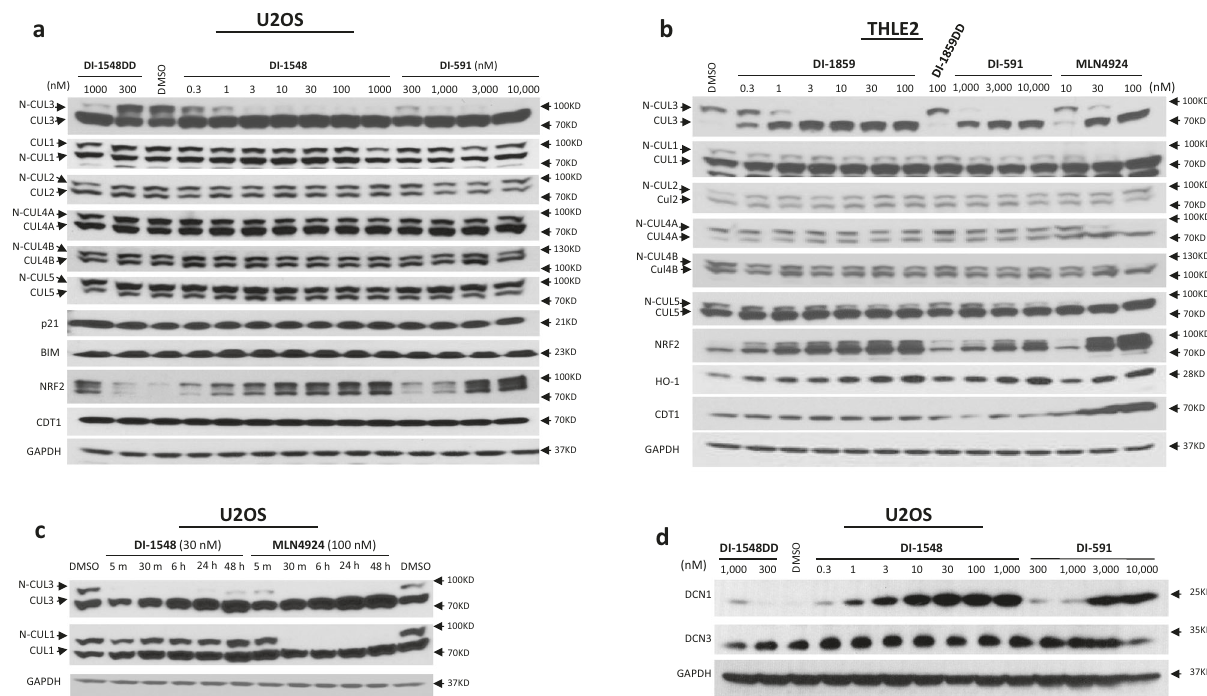
Fig. 6 DI-1548 and DI-1859 selectively inhibit cullin 3 neddylation in different types of cells. The effects of a dose range of the indicated compound on the protein level in osteosarcoma U2OS ( a ) and in immortalized THLE2 liver cell lines ( b ). The protein levels of neddylated cullin 3, 1, 2, 4A, 4B, and 5 (N- Cul3, 1, 2, 4A, 4B, and 5) and unneddylated cullin 3, 1, 2, 4A, 4B, and 5 (Cul3, 1, 2, 4A, 4B, and 5), as well as the substrates of cullins mediated CRLs, including p21, Bim, Nrf2 and CDT1, and HO-1 were examined by western blotting analysis. GAPDH was used as a loading control. c DI-1548 rapidly and selectively inhibits the neddylation of cullin 3 in osteosarcoma U2OS. The protein levels of neddylated cullin 3, 1 (N-Cul3, 1) and unneddylated cullin 3, 1 (Cul3, 1) were examined by western blotting analysis. GAPDH was used as a loading control. d DI-1548 effectively engages cellular DCN1 protein. U2OS cell line was treated by dose ranges of compounds DI-1548, DI-1548DD, or DI-591 for 1 h, then was heated at 53 °C. The cells were snap frozen in liquid nitrogen and thawed for three cycles. The levels of DCN1 and DCN3 in whole cell lysates were examined by western blotting analysis. GAPDH was used as a loading control. Representative images of two independent experiments are shown for a – d . Source data are provided as a Source Data fi